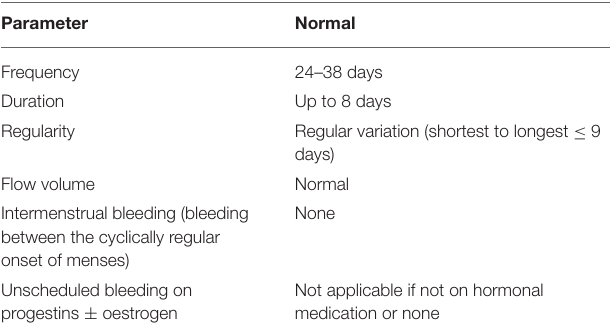
TABLE 1 | International Federation of Gynaecology and Obstetrics (FIGO) Abnormal Uterine Bleeding System 1 definitions for normal menstrual bleeding [(2). doi: